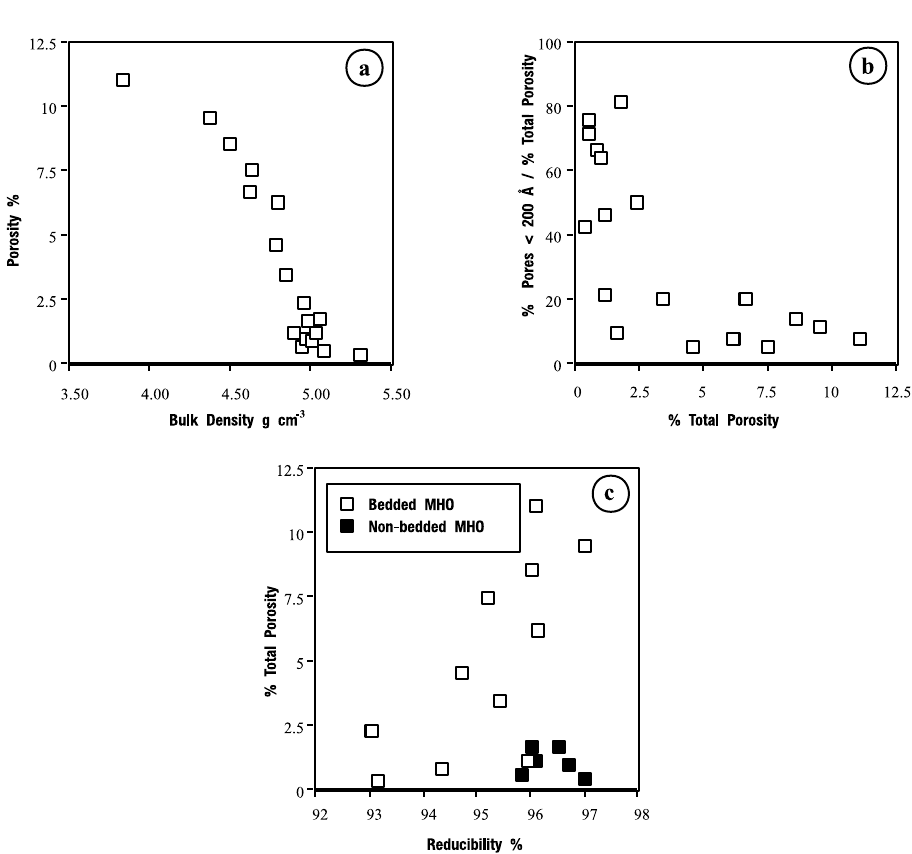
Fig. 5 – (a) Comparison between porosity (%) and bulk density (g cm –3 ) of MHO; (b) comparison between total porosity (%) and the pore volume obtained by nitrogen desorption (D < 200Å ) (%); (c) comparison between porosity (%) and reducibility (%) of bedded and non-bedded